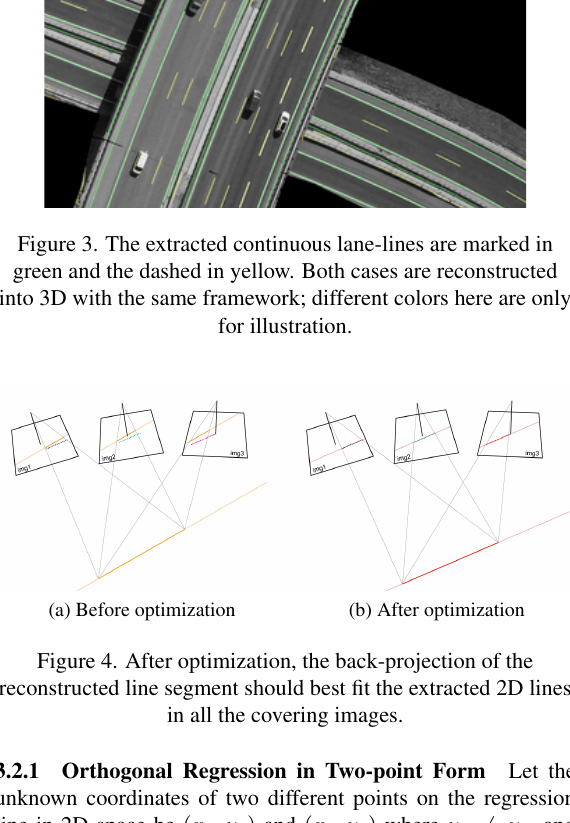
(a) Pink points represent the extracted lines. The greens are the endpoints of the back projected approximate 3D line segment. Figure 6. collection of affected lane marking